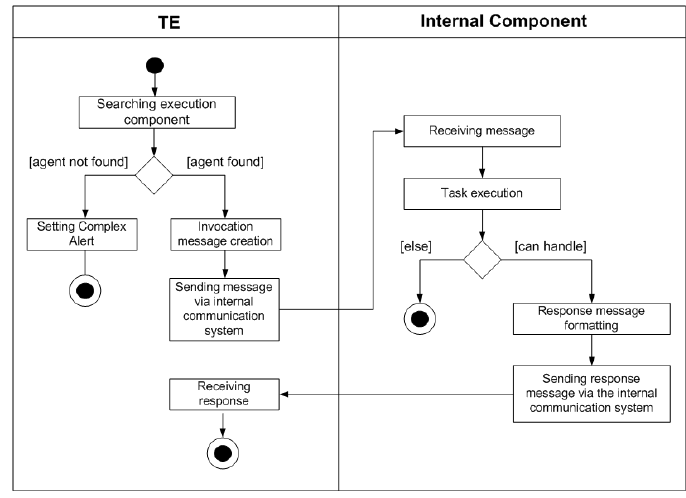
Figure 4. Activity diagram of the sub-activity executing